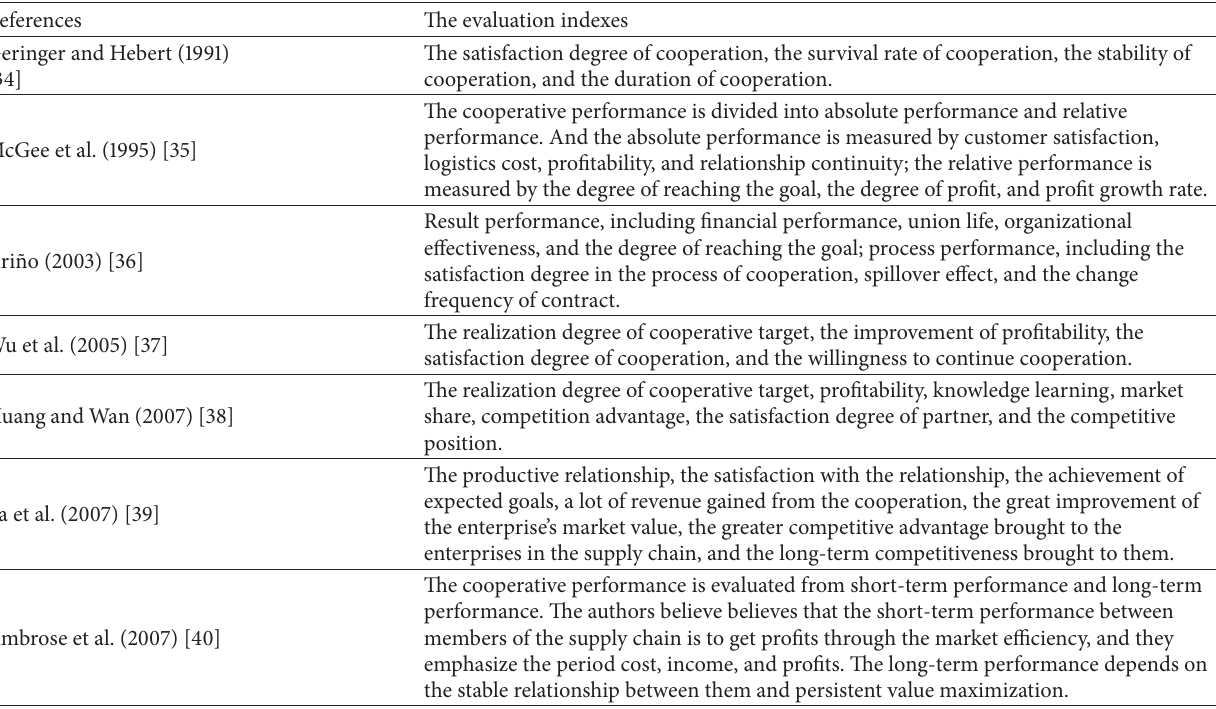
Table 2: The subdivision indexes of cooperative performance.